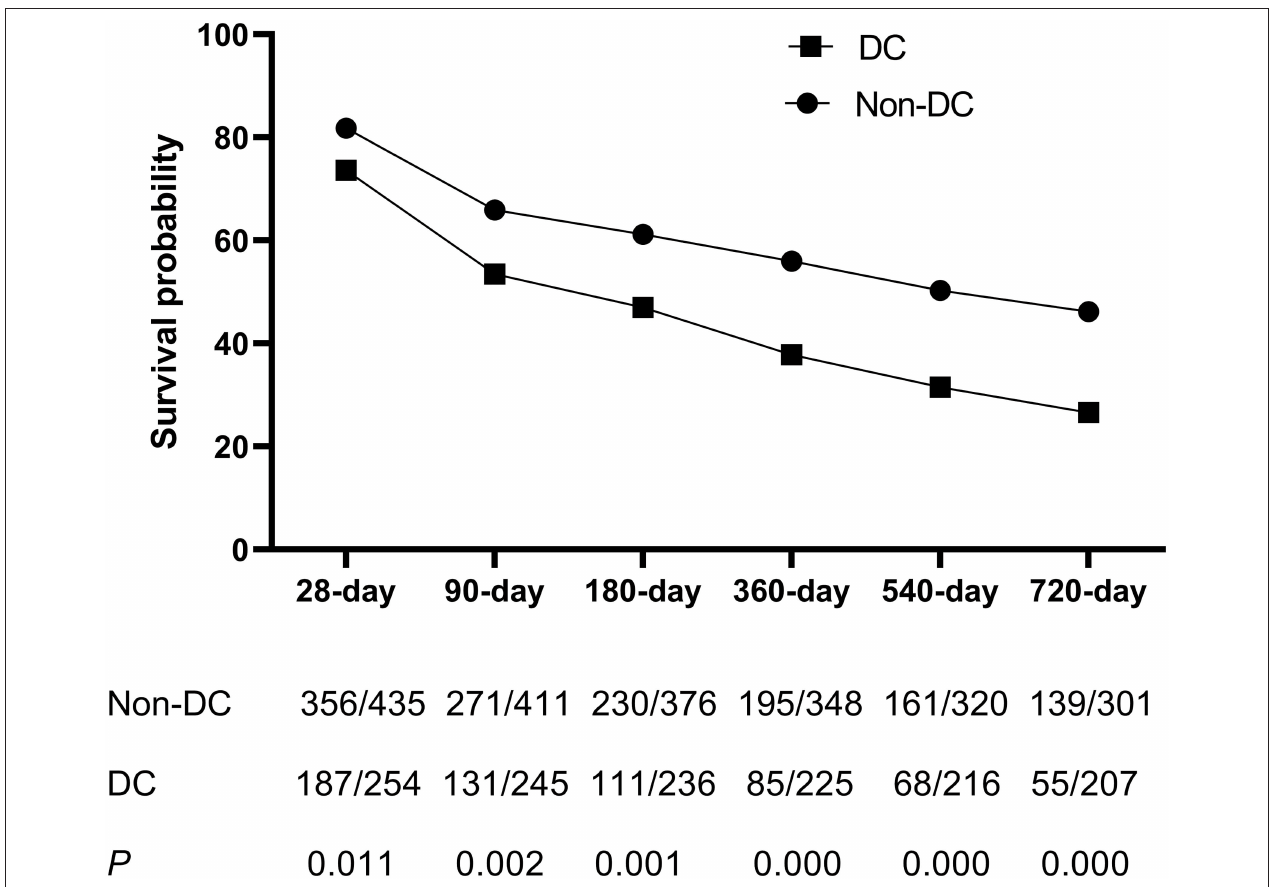
FIGURE 3 | The survival analysis of patients with ACLF between DC group and non-DC group during 28, 90, 180, 360, 540, and 720 days.